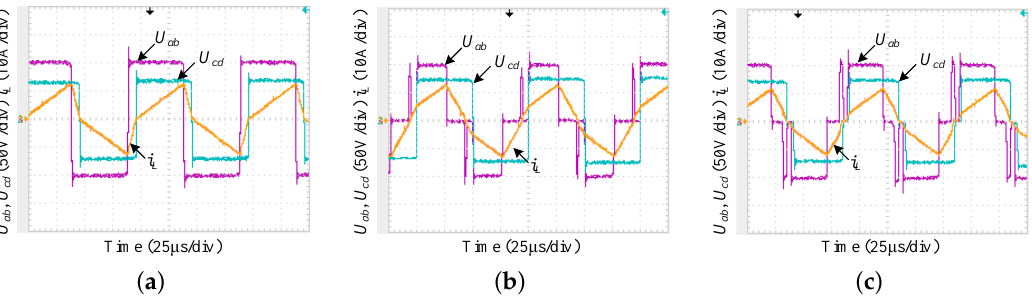
Figure 19. Experimental waveforms of DAB converter with M min = 0.15, k = 1.5, U 1 = 100 V, P = 400 W: ( a ) SPS scheme; ( b ) UTPS scheme; and ( c ) TPSiDT